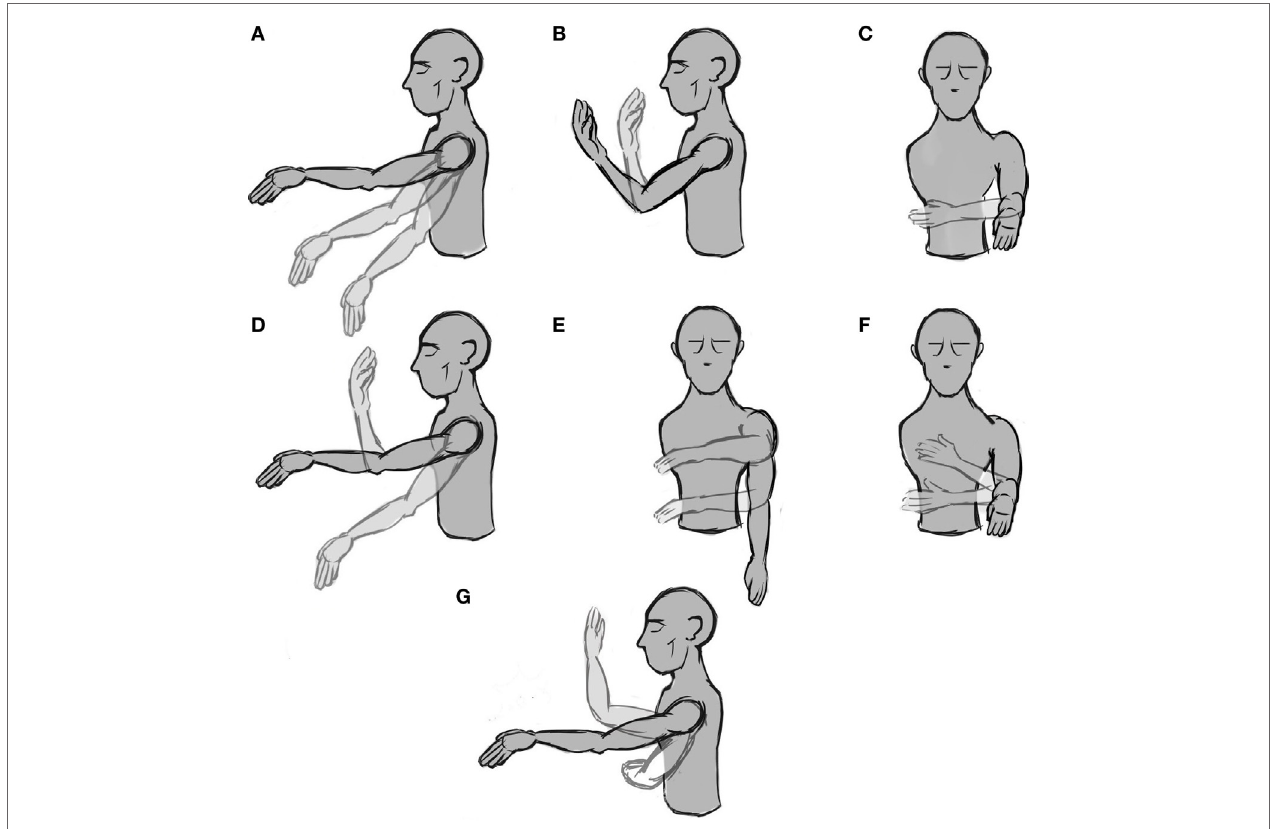
FigUre 1 | representation of the seven phases with movement . (a–c) simple movements, i.e., the motion occurs only on one DoF, (D–F) combined movements, i.e., the movement occurs on two DoFs, and (g) the hand’s free